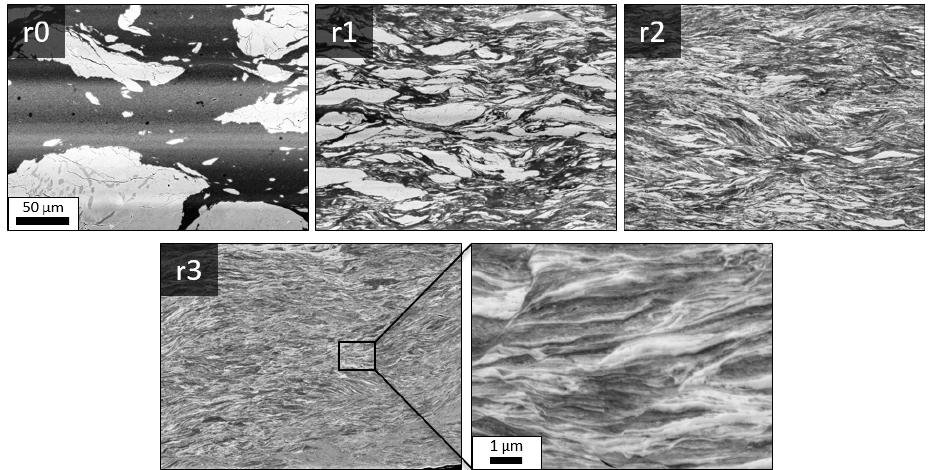
Figure 2. BSE images at the same magnification of a HPT-deformed sample at RT consisting of 47 wt.% Fe–53 wt.% SmCo 5 at different radii. The higher magnified image is taken at r = 3 mm.